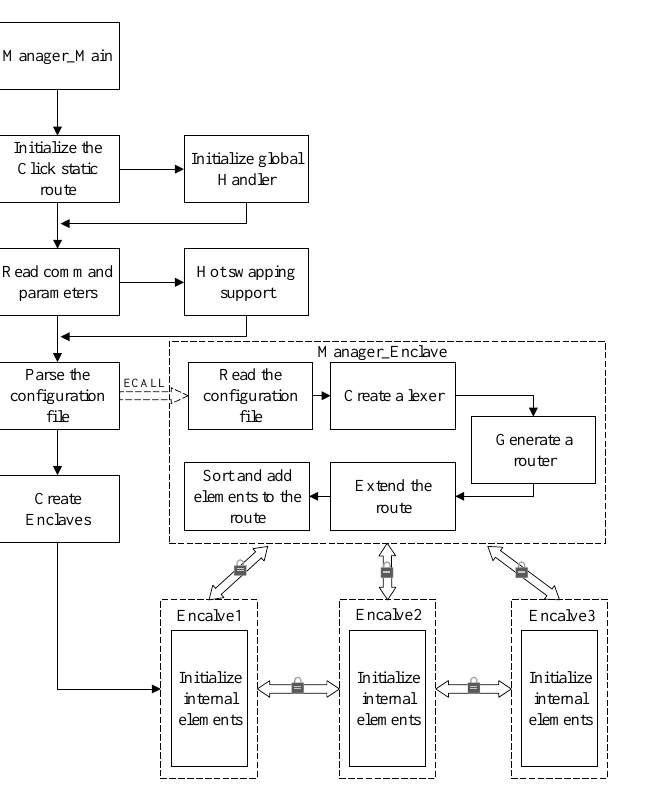
Figure 4. Secure